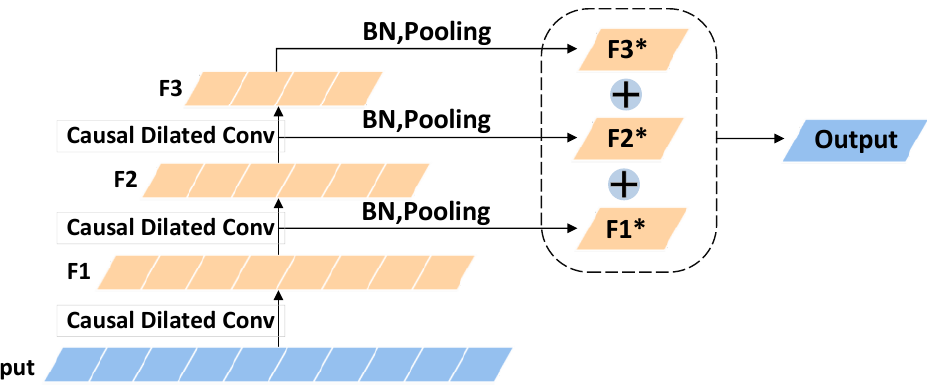
Figure 2. The feature pyramid structure of time series.